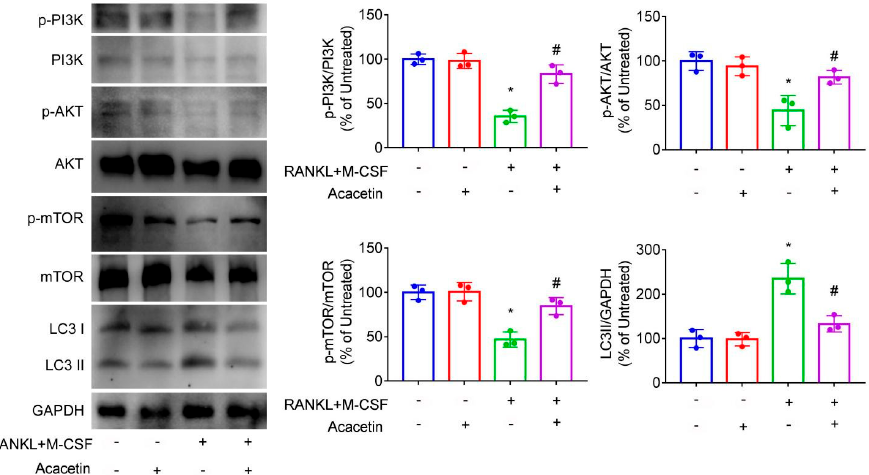
Figure 5. BMMs were stimulated with RANKL (50 ng/mL) and M-CSF (25 ng/mL) in the presence of acacetin (25 µ M) for 6 h. Western blotting results and responding quantification of PI3K phosphorylation, AKT phosphorylation, mTOR phosphorylation, and LC3II expression were shown. * p < 0.05 versus the vehicle-treated group; # p < 0.05 versus the RANKL+M-CSF group, n = 3. Co-treatment with rapamycin, an activator of autophagy, abolished the inhibitory effect of acacetin on the protein levels of LC3II (Figure 6A).